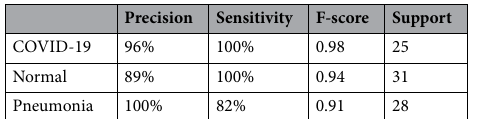
Table 1. Assessment of evaluation metrics for three target class labels using 84 test